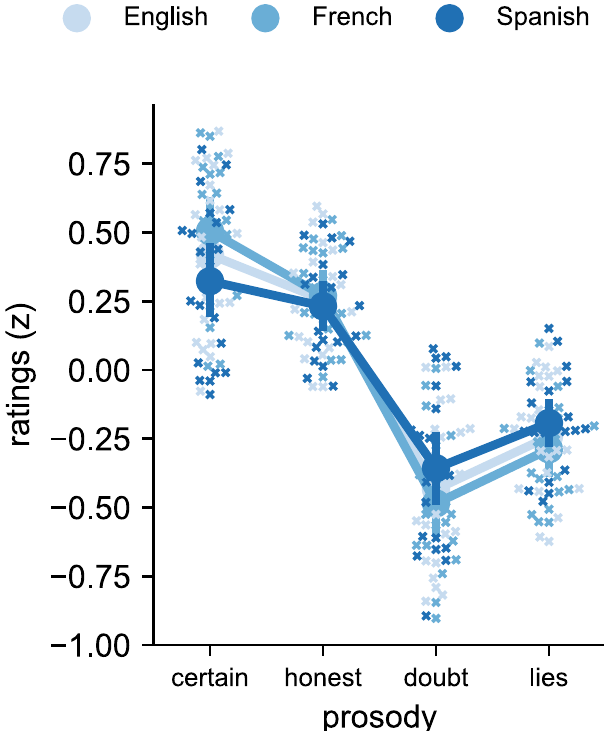
Fig. 4 Cross-linguistic validation for the certainty task including the group of French speakers ( N = 20), a group of native English speakers ( N = 22), and a group of Spanish speakers ( N = 21). Normalized ratings ( z -scored) were averaged separately for each prosodic archetype and language group. Data are presented as mean values with error bars showing the 95% con fi dence interval. Crosses represent individual data for each prosodic archetype and native language. As was the case in the group of French speakers, Spanish and English speakers perceived certain/honest archetypes to be more certain than doubt/lies archetypes (see main text for details). They also judged certain prosody to be more certain than honest prosodies ( p < 0.005, N = 21 Spanish speakers: d = 0.4; N = 22 English speakers: d = 0.7) and lying prosodies to be more certain than doubtful prosodies ( p < 0.001, Spanish: d = 0.7; English: d = 0.8), showing the same sensitivity to small variations in the gain of the archetypes. Source data are provided as a Source data fi